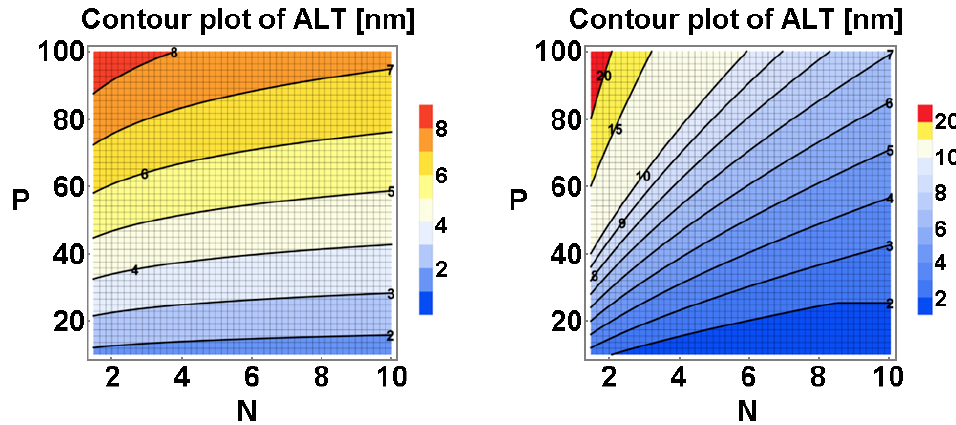
Figure 4. Contour plots of the adsorption layer thickness (ALT) at high surface coverage; results are insensitive to the numbers of side chains (n): the Flatt model ( left ) and the surface-tethered chain model ( right ); data taken from [47].